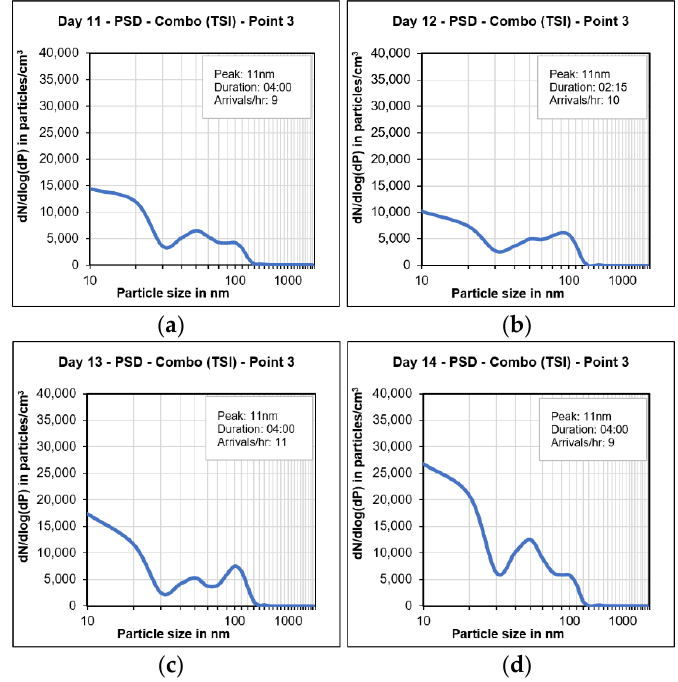
Figure 7. Daily average PSDs on ( a ) day 11, ( b ) day 12, ( c ) day 13, ( d ) day 14 (phase 3). On day 15, the arrivals first of all flew over point 3, as on the previous days. However, the flight path changed mid-morning due to the changing wind direction, and the depar- tures began taking off over point 3. The highest particle number concentration was ini- tially at 10 nm when the arrivals were measured (Figure 8a) but then shifted to 48 nm when the departures were measured (Figure 8b). During the departures, the aircrafts gained altitude at a quick rate which was assumed to be too high to measure by the time they flew over point 3. ( a ) ( b ) Figure 8. PSDs on day 15 at point 3 of ( a ) arrivals and ( b ) departures. The measurement location was then moved to point 1 on the west side of the airport to continue measuring the arrivals and the same pattern was seen again. Only three